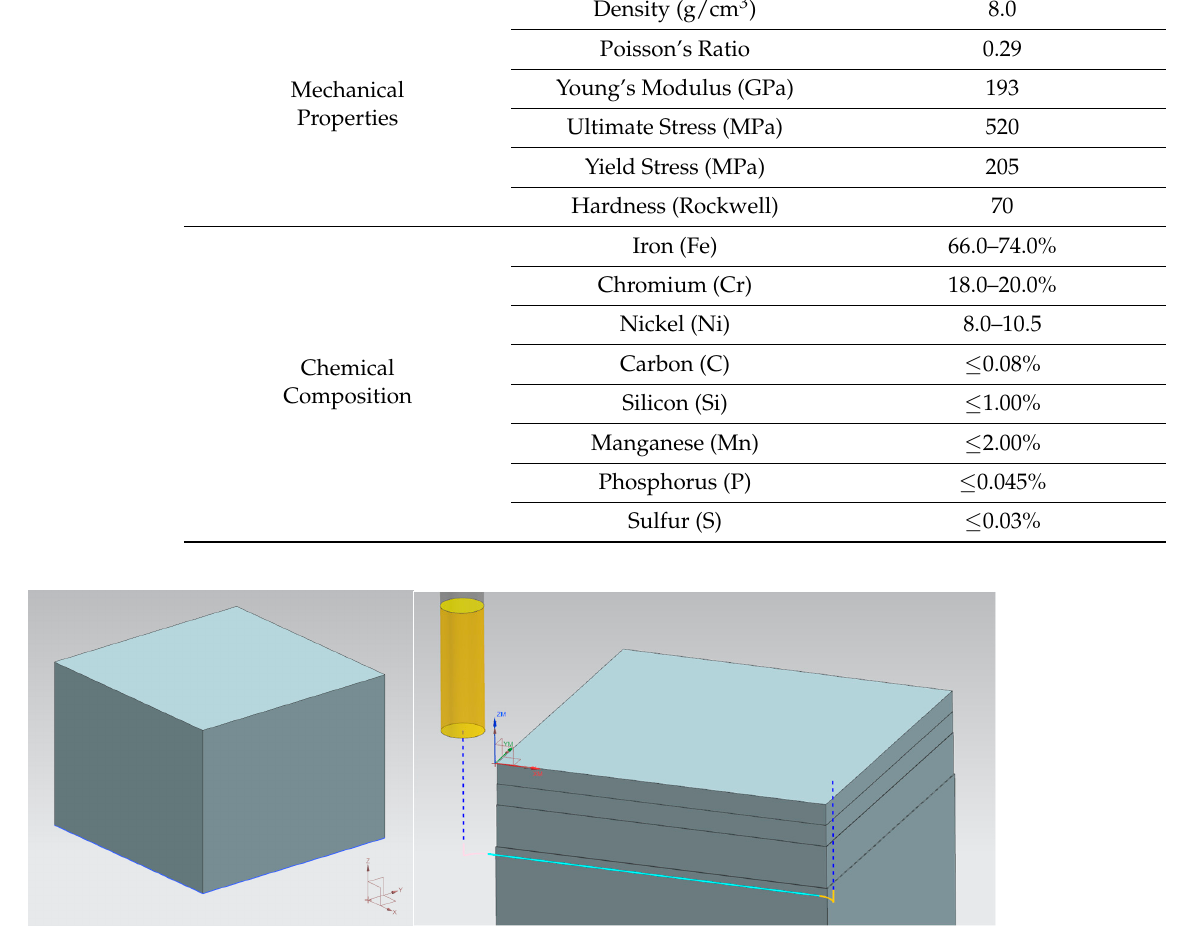
Table 1. Mechanical properties and chemical composition of SUS304.